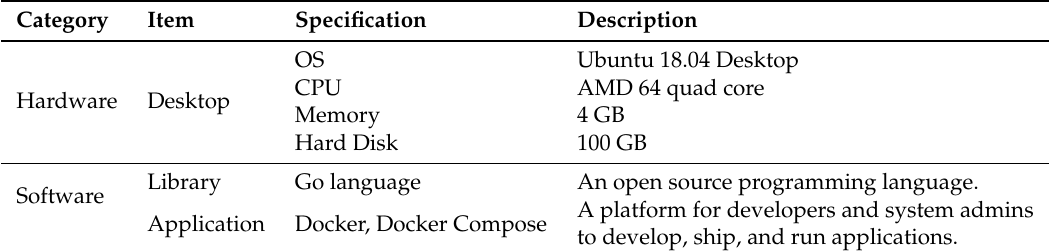
Table 1. Hardware and software specifications for microservice